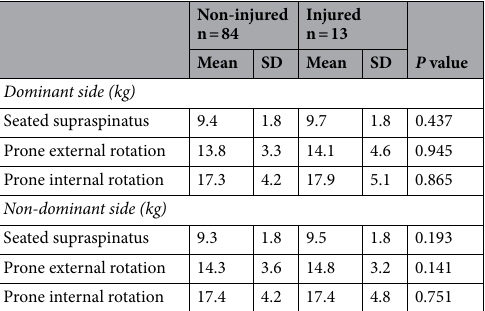
Table 2. Shoulder strength. SD, standard deviation. * P <